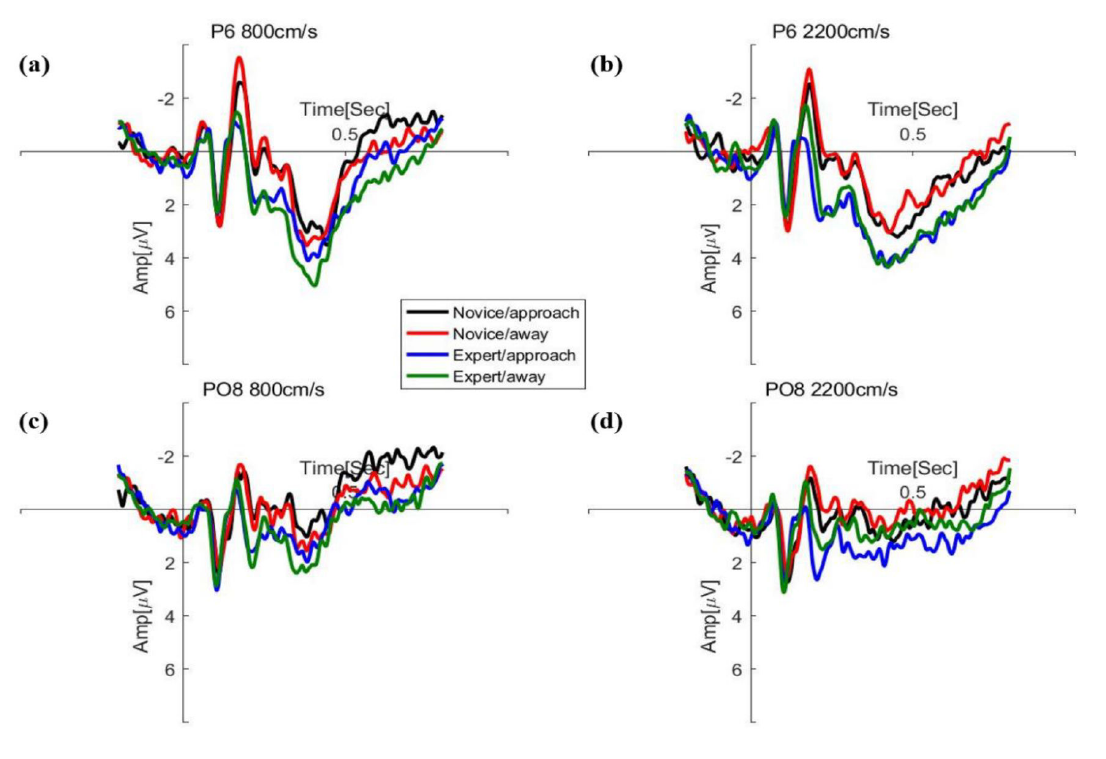
Figure 5. The grand–average waveform for expert and novice at speeds of 800 cm/s ( a , c ) and 2200 cm/s ( b , d ) in the occipital region.